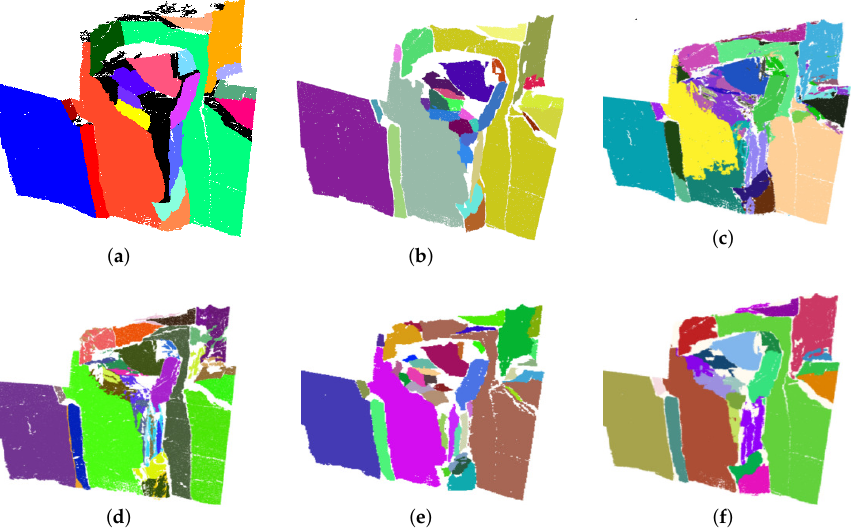
Figure 12. Segmentation results. ( a ) Reference point clouds. ( b ) Ours. ( c ) PCL-RAN. ( d ) DSE. ( e ) HTRG. ( f )